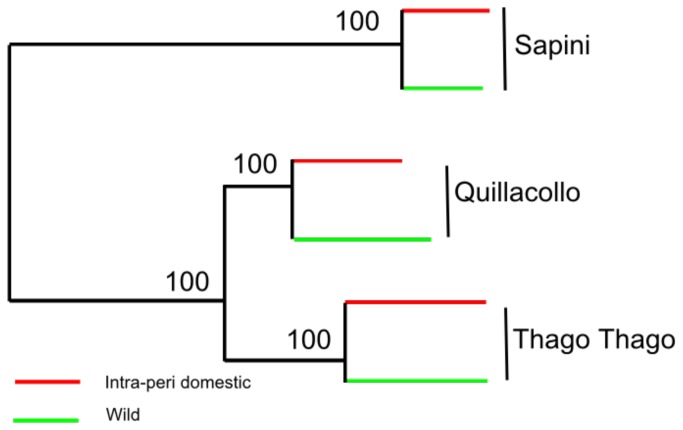
Neighbor-joining between wild and intra-peridomestic populations.The tree was built from Cavalli Sforza’s genetic distances between the six populations that grouped, in each locality (bugs collected in the wild and the intra-peridomestic environments). The bootstrap values are expressed at the nodes of the branches.